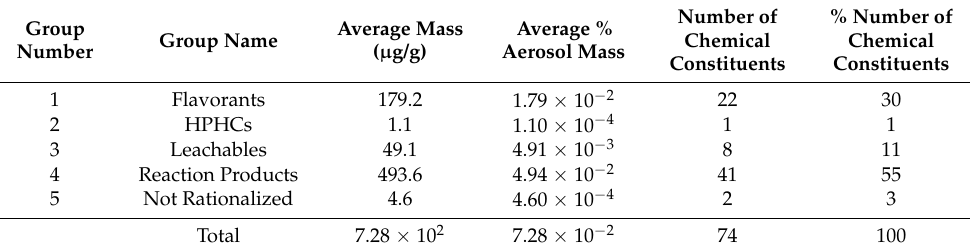
Table 3. Summary of non-targeted analyses of Me3 aerosol constituents detected by GC and/or LC NTA methods using the intense puffing regimen.